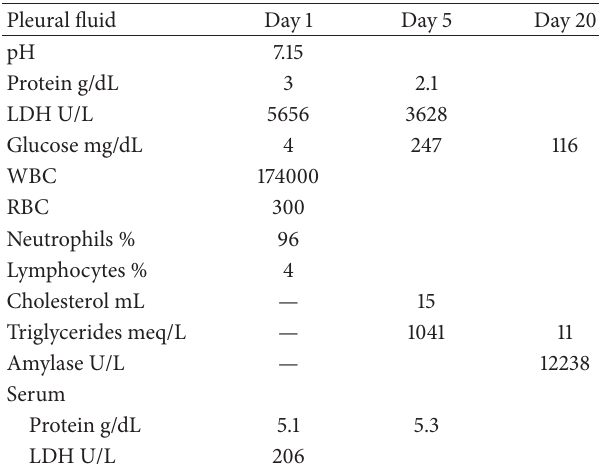
liters oxygen), tachycardic (heart rate of 120/min), tachypneic Table 1: Description of pleural fluid